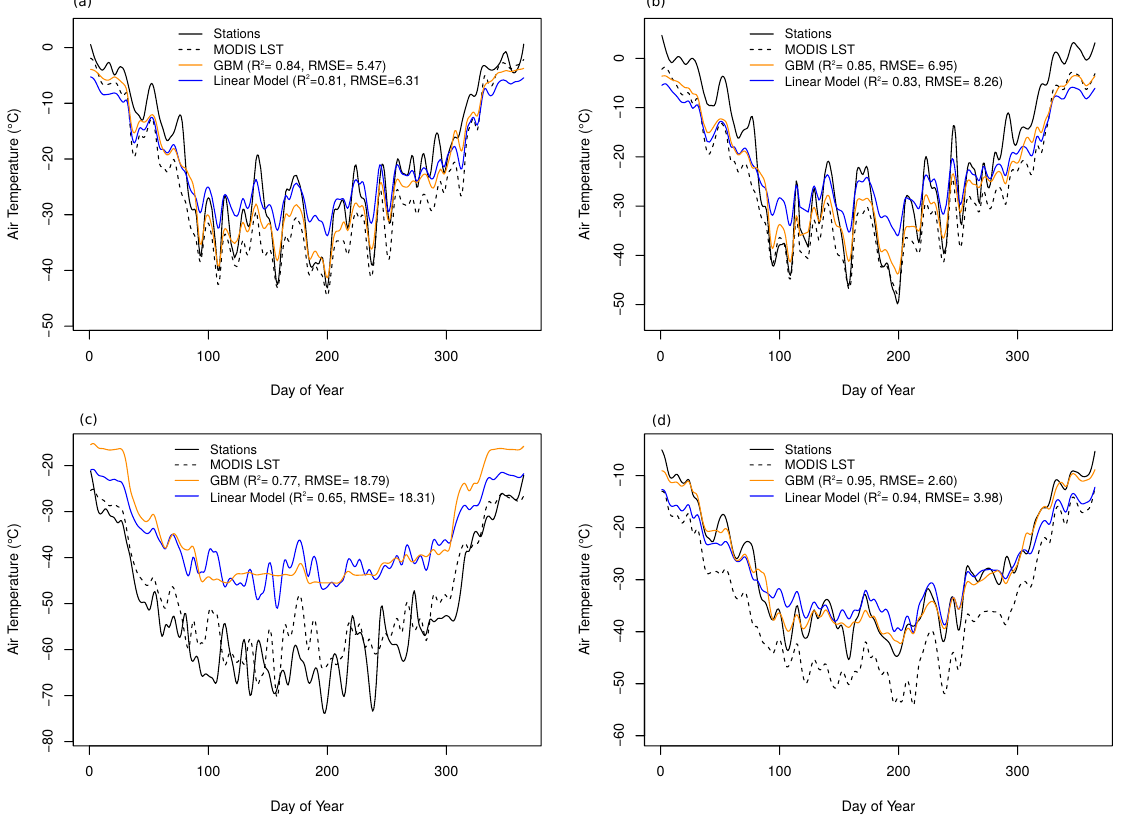
Figure 6. Time series of the three example weather stations ( a ) “Brownworth”, ( b ) “Bull pass” and ( c ) “Harry”, as well as ( d ) the average time series of all 32 weather stations for the year 2013. “Brownworth” and “Bull pass” are weather stations located in the McMurdo Dry Valleys. “Harry” is located on ice. The lines represent the measured T air (solid black), MODIS LST (dotted black), GBM model predictions (orange), as well as linear model predictions